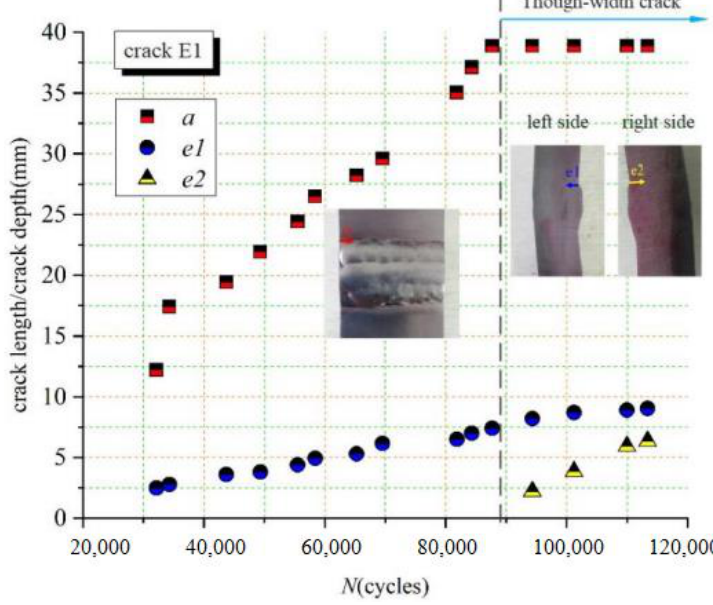
Figure 15. Crack growth versus cycles in positions E1.